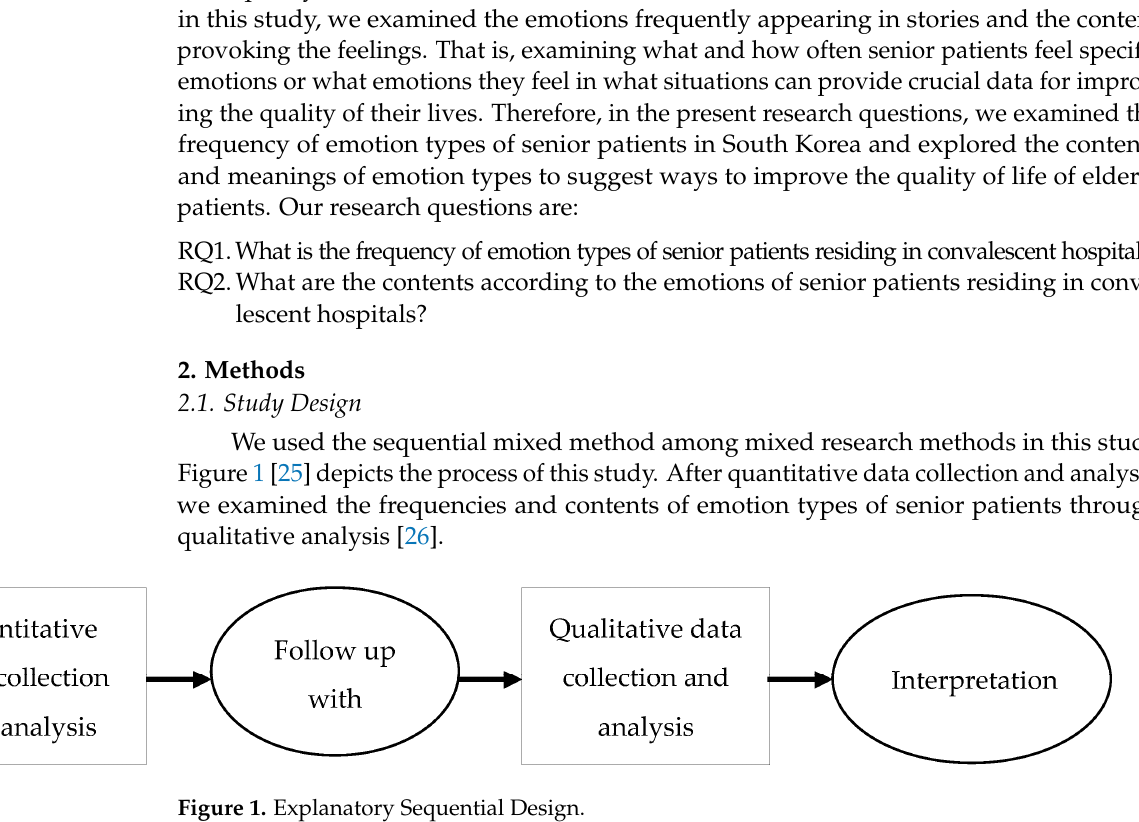
Figure 1. Explanatory Sequential Design.